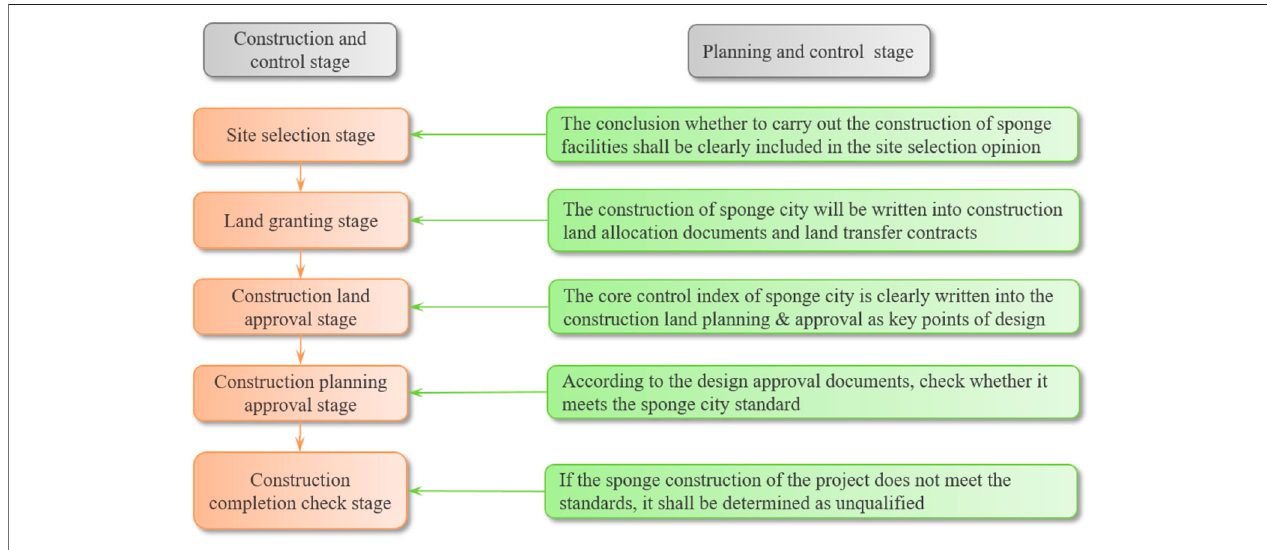
FIGURE 3 | Procedures of Sponge city construction project in